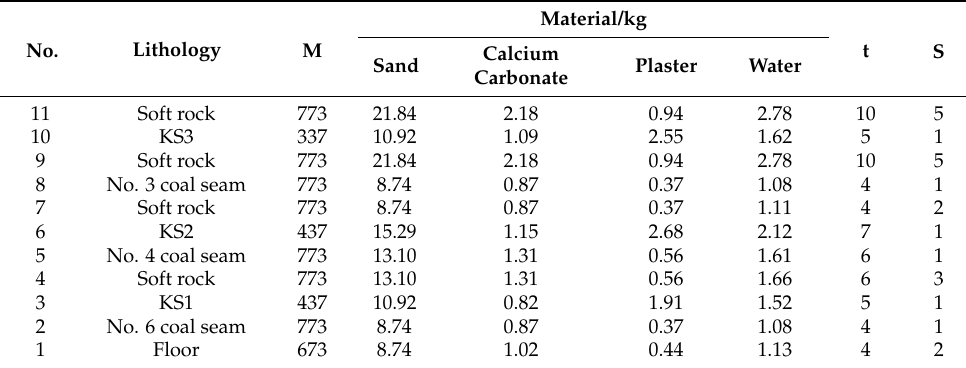
Table 1. Proportion table of similar